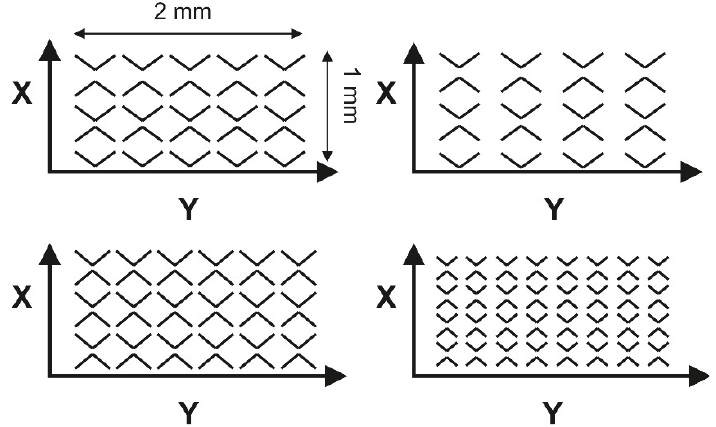
Figure 6. Patterns of chevrons analyzed in [68], X–direction according to cylinder axis. Vl ă descu et al. [70] found that grooves of nearly 8 µm depth normal to the sliding direction reduced friction to 63% in boundary and mixed friction, due to decreasing asperity contact. Angular grooves, chevrons, and crosshatch grooves led to smaller friction reduction. Grooves parallel to the sliding direction led to an increase in friction, compared to smooth samples. At the full film regime, surface texturing led to an increase in friction compared to the smooth surface. The stroke was 26.8 mm.